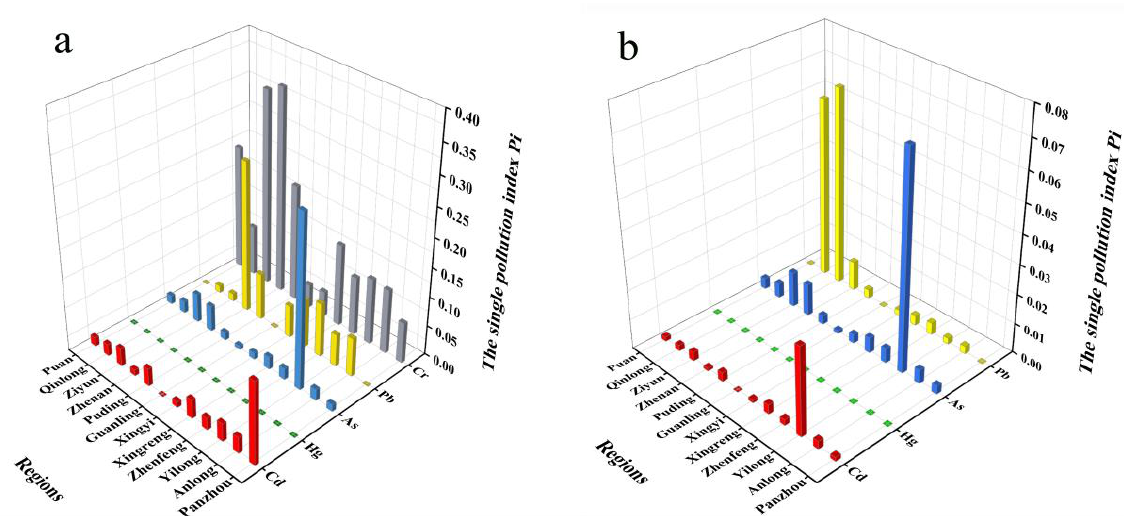
Figure 2. The single pollution index was conducted with reference to CSGB ( a ) and CP ( b ). As exhibited in Table 4, L values in the coix seed decreased in the order of Pb > As > Table 4. The evaluation of heavy metal pollution degree. Cd > Hg, using CP as the evaluation standard, while the order of L values was Cr > Pb > Hg > As > Cd, using CSGB as the evaluation standard. Pb and Cr were the main heavy